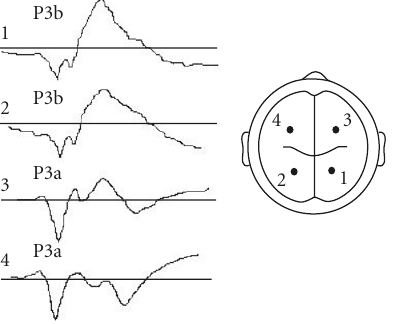
Figure 1: Some examples for P3b (1 and 2) and P3a (3 and 4) sig- nals and their corresponding typical